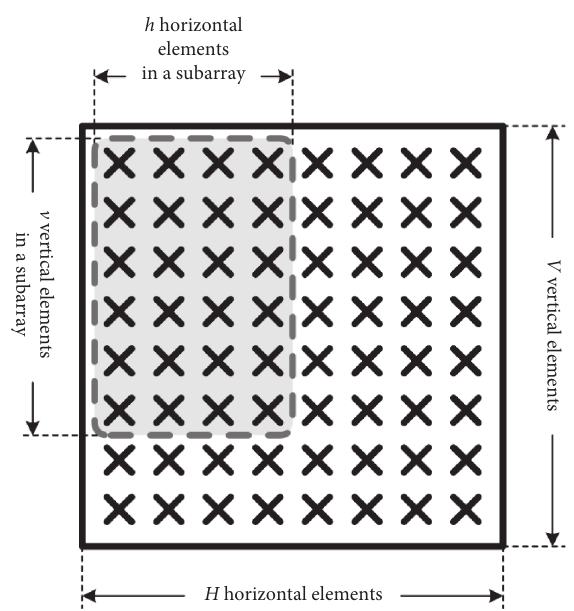
Figure 2: A uniform planar array including subarrays for hybrid